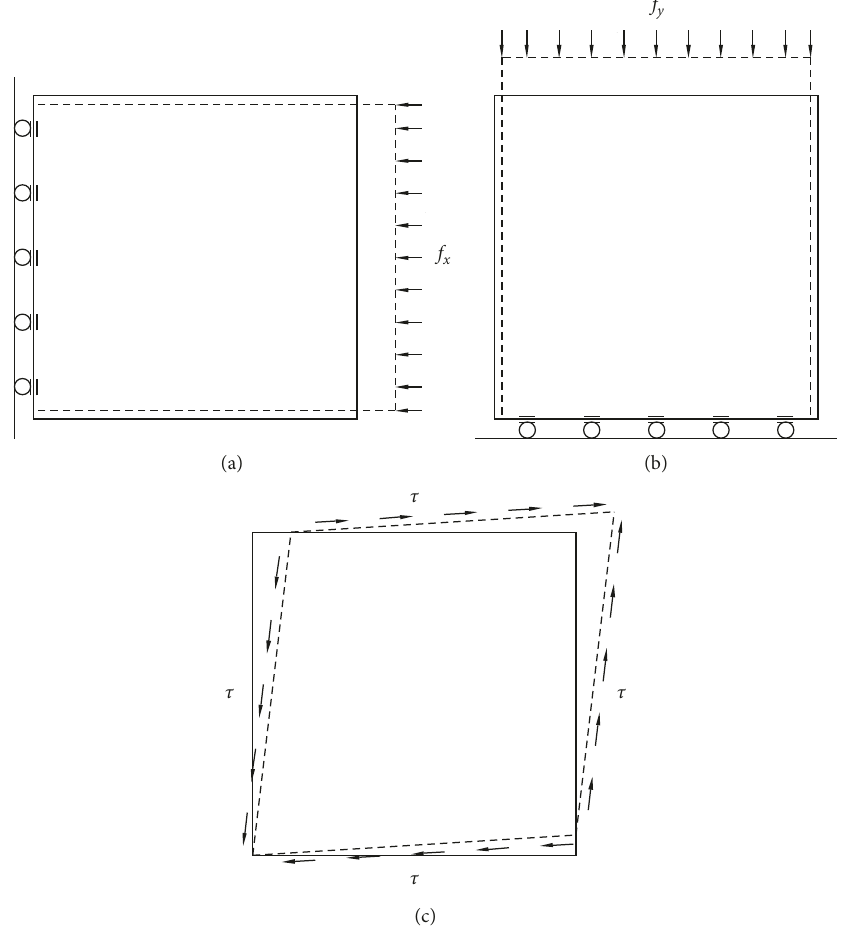
Figure 13: Three loading sets: uniaxial compression in the x direction (case a) (a), uniaxial compression in the y direction (case b) (b), and pure shear test (case c) (c) to determine five homogenized components S 22 , S 23 , S 32 , S 33 , and S 44 of fractured rock